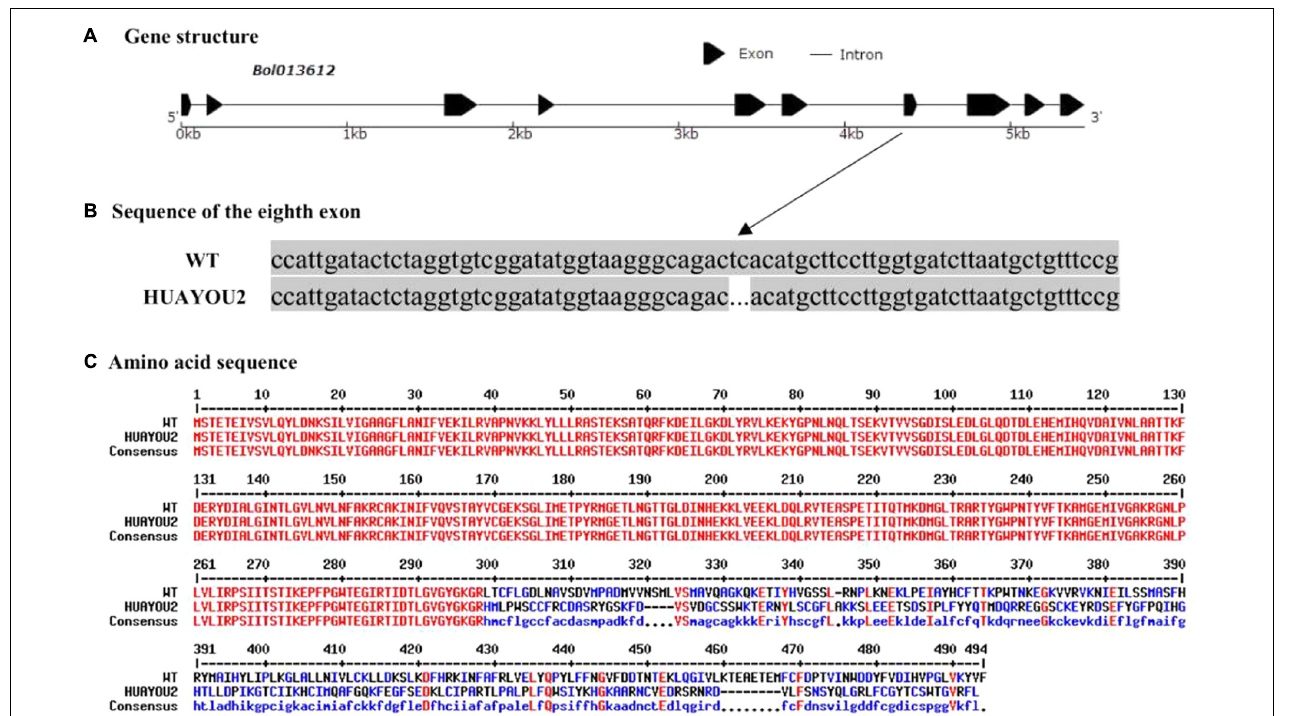
FIGURE 4 | The gene structure and alleic variation in Bol013612 (A) . Sequence alignment of exon 8 showing two bp deletion in HUAYOU2 as compared to WT (B) . Amino sequence alignments showing premature stop codon (indicated with arrow) due to a frameshift mutation in Bol013612 gene in HUAYOU2 (C) .